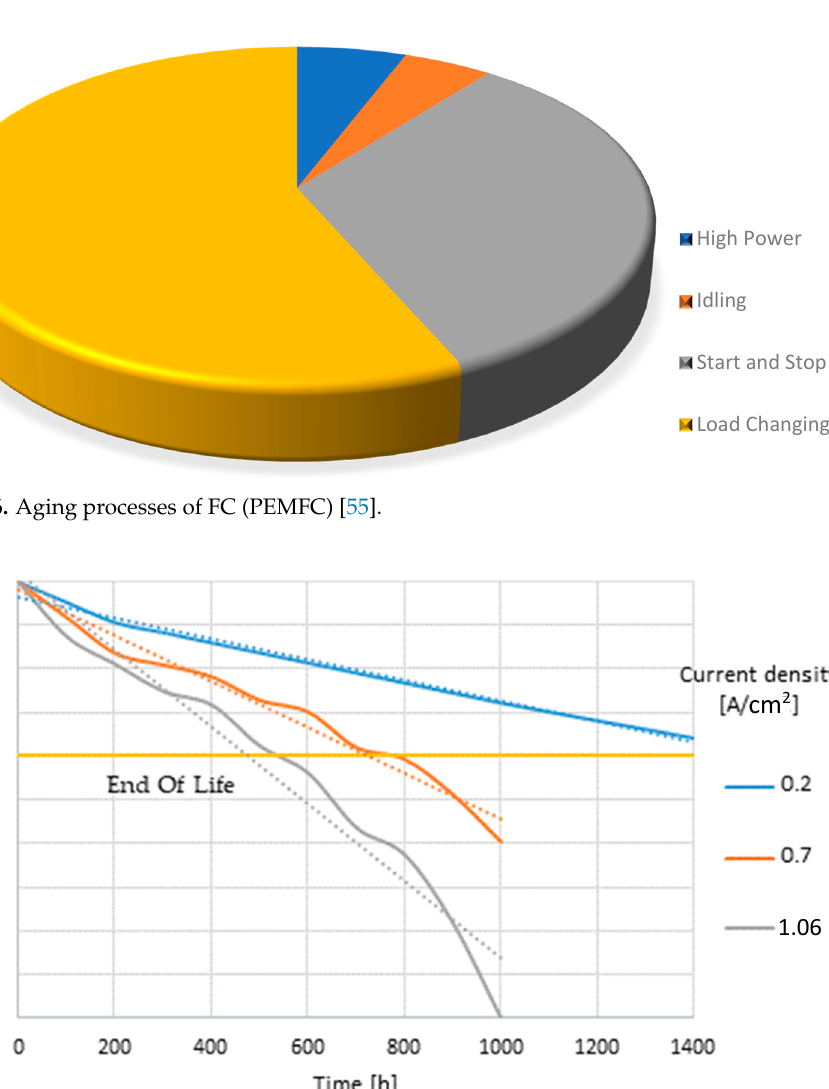
Figure 8. Current Density—FC aging model.